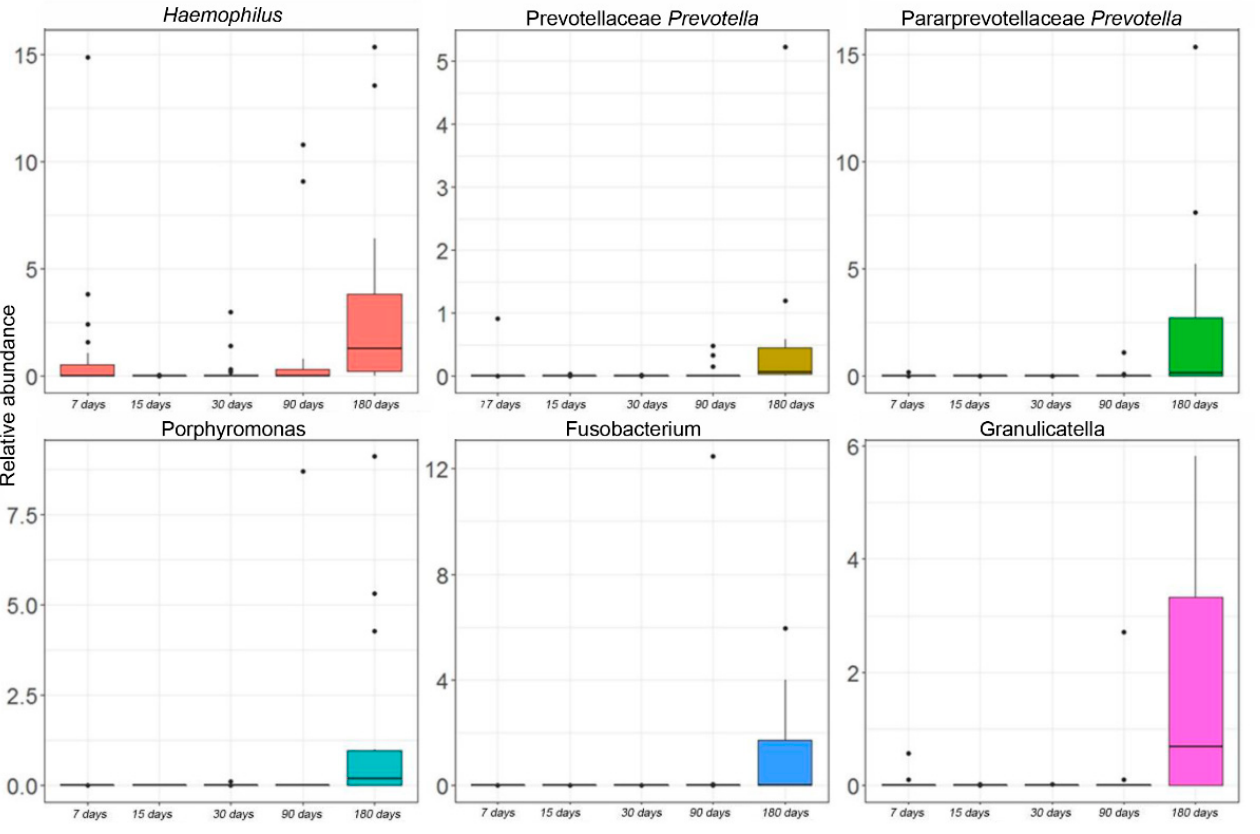
Figure 3. Kruskal–Wallis test-based OTU distribution of the salivary microbiota. The bar graphs represent the average distribution of the OTUs at the genus level in salivary microbiota during the first six months of infant’s age. Only statistically significant OTUs with p FDR < 0.05 are shown. From an analysis of the OTUs that were shared between all-time points, we were able to identify a temporal core microbiota in the saliva samples (Supplementary Table